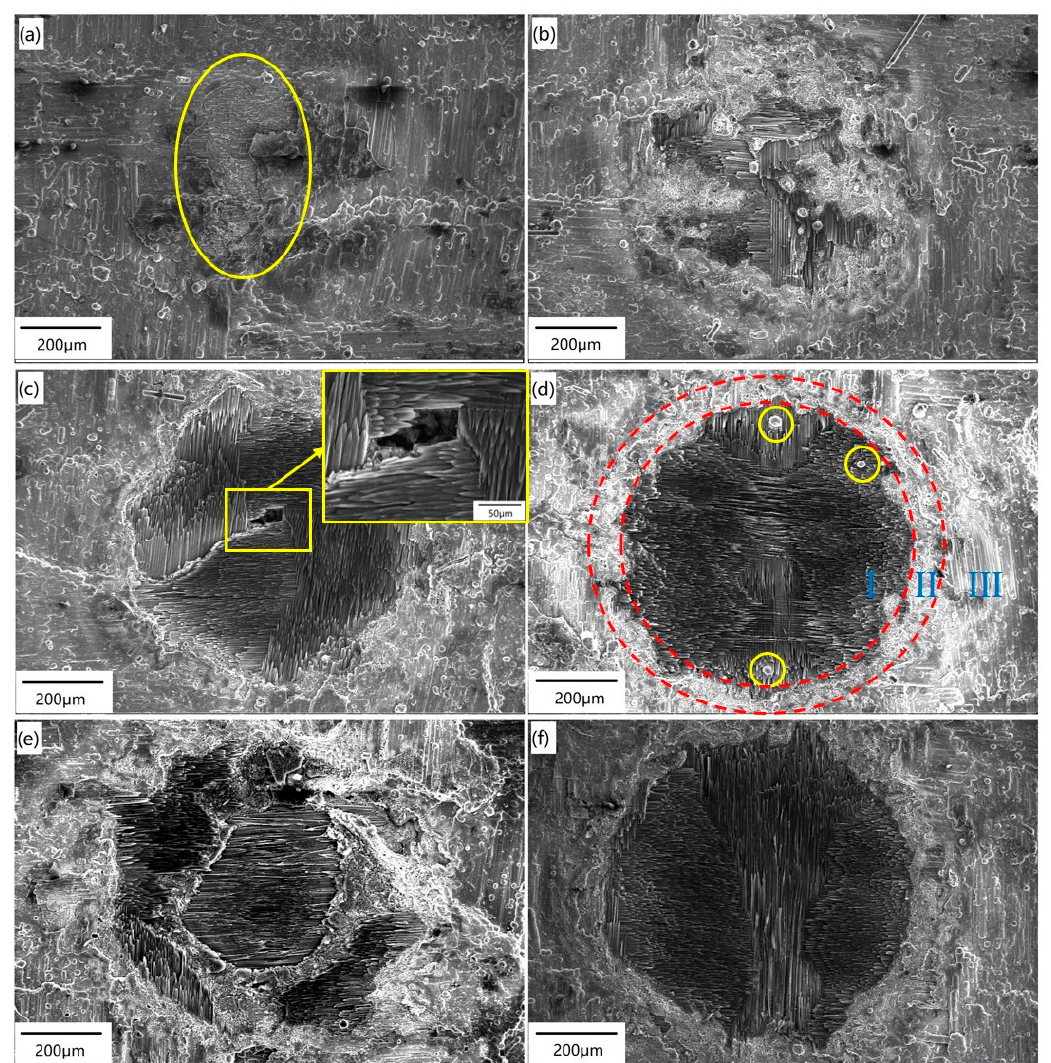
Figure 3. Surface morphology of the C/SiC composite irradiated by a single pulse. ( a ) Condition A; ( b ) Condition B; ( c ) Condition C; ( d ) Condition D; ( e ) Condition E; ( f ) Condition F.